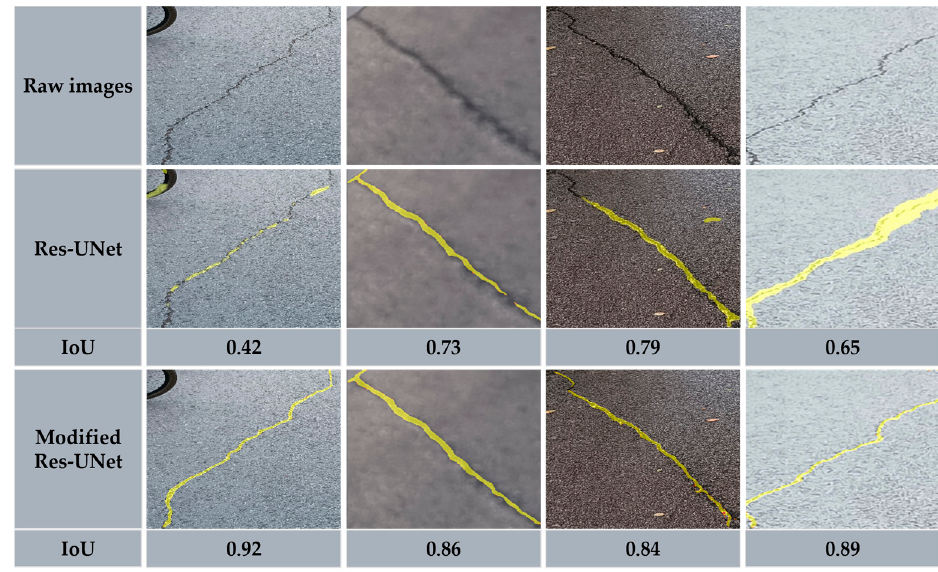
Figure 12. Comparisons of the original and modified Res-UNet to segment cracks from the origi- nal images.